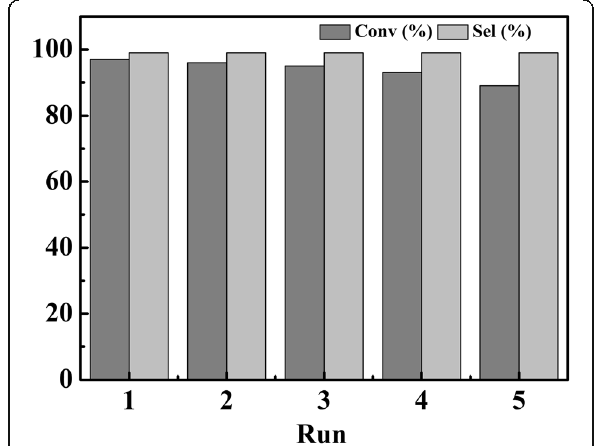
Fig. 7 Catalytic reusability of TPDB-BP-TEA for cycloaddition of CO 2 with PO. As a solid catalyst, TPDB-BP-TEA is recovered readily by filtration or centrifugation and well maintain its activity in the five-run recycling test under mild conditions